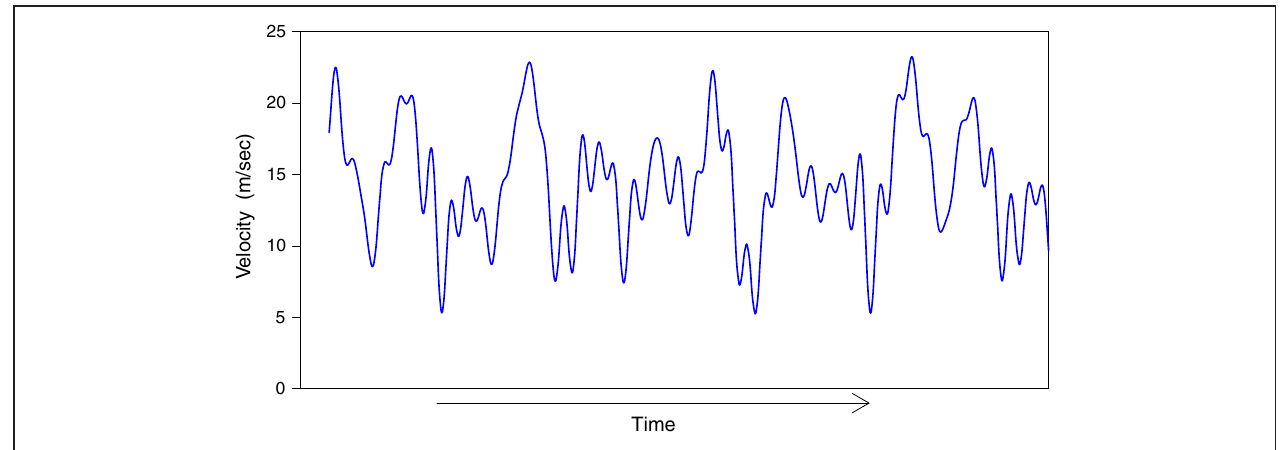
FIGURE 2 | Example of the perturbed speed of the lead-object as a function of